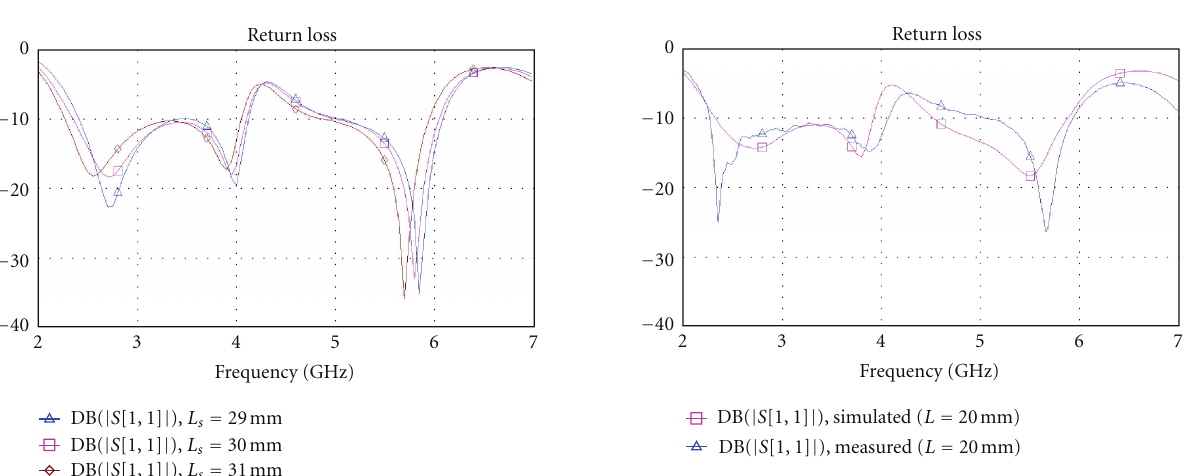
Figure 6: Simulation return loss of hybrid DR antenna with di ff erent rectangular slot length.